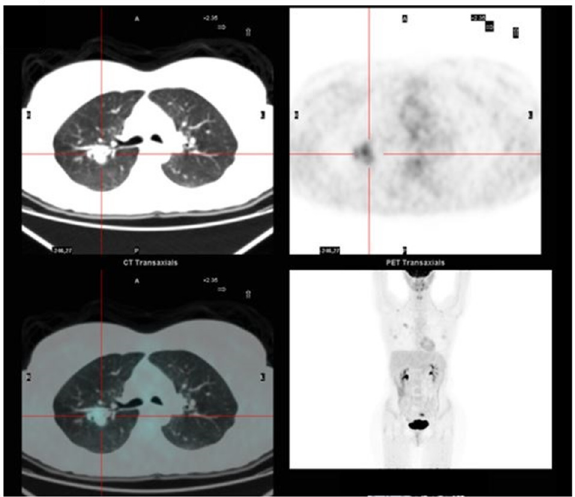
Figure 2. 18 F-FDG-PET of the pulmonary